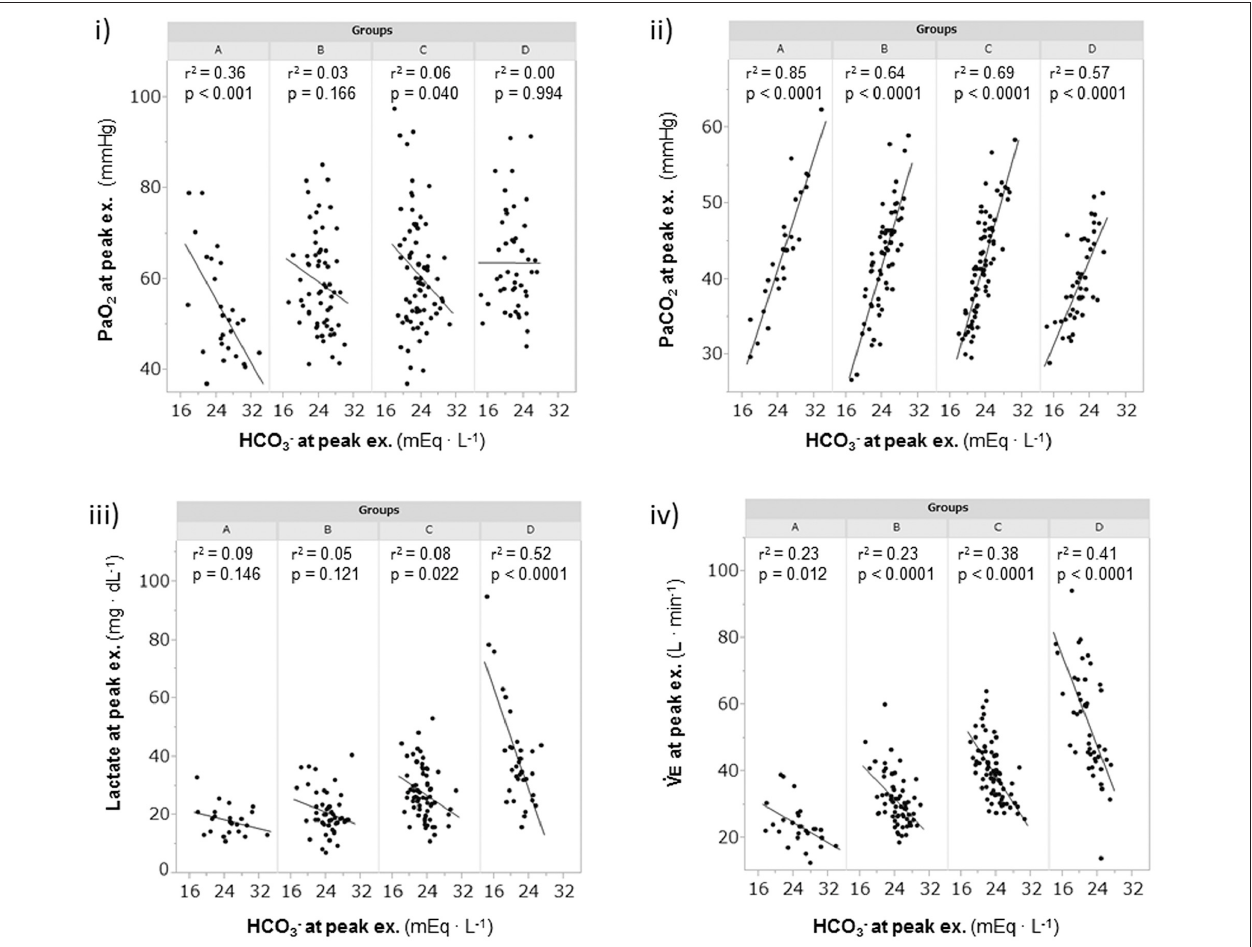
FIGURE 5 | The relationships of the HCO − 3 levels at peak exercise during cardiopulmonary exercise testin. (i) relationship between PaO 2 and HCO − 3 , (ii) relationship between PaCO 2 and HCO − 3 , (iii) relationship between lactate and HCO − 3 , and (iv) relationship between ˙ V E and HCO − 3 . Group A ( < 11 mL · min − 1 · kg − 1 ); group B (11 to < 15 mL · min − 1 · kg − 1 ); group C (15 to < 21 mL · min − 1 · kg − 1 ); and group D ( ≥ 21 mL · min − 1 · kg − 1 ). HCO − 3 , bicarbonate ion; PaCO 2 , arterial carbon dioxide tension; PaO 2 , arterial oxygen tension; ˙ V E , minute